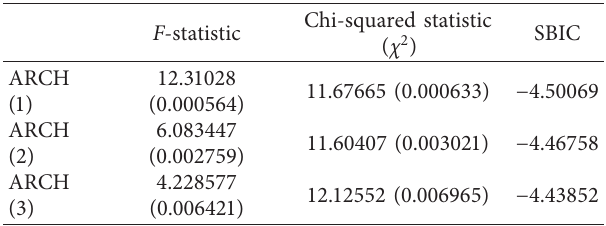
Table 4: Test of serial correlation and normality for the residuals of the tentatively fitted ARMA (1, 3) model.